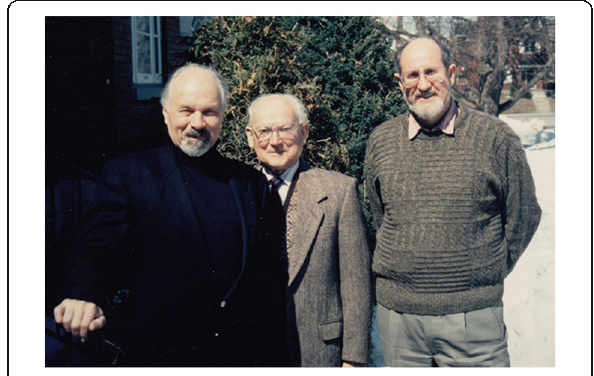
Fig. 24 “ Stan ” Hughes ( centre ) with Kris Pirozynski ( left ) and Charles Stirton, the first Director of the National Botanic Garden of Wales, now the home of the Stanley Hughes Library ( right ); in front of Hughes ’ residence in Ottawa, winter